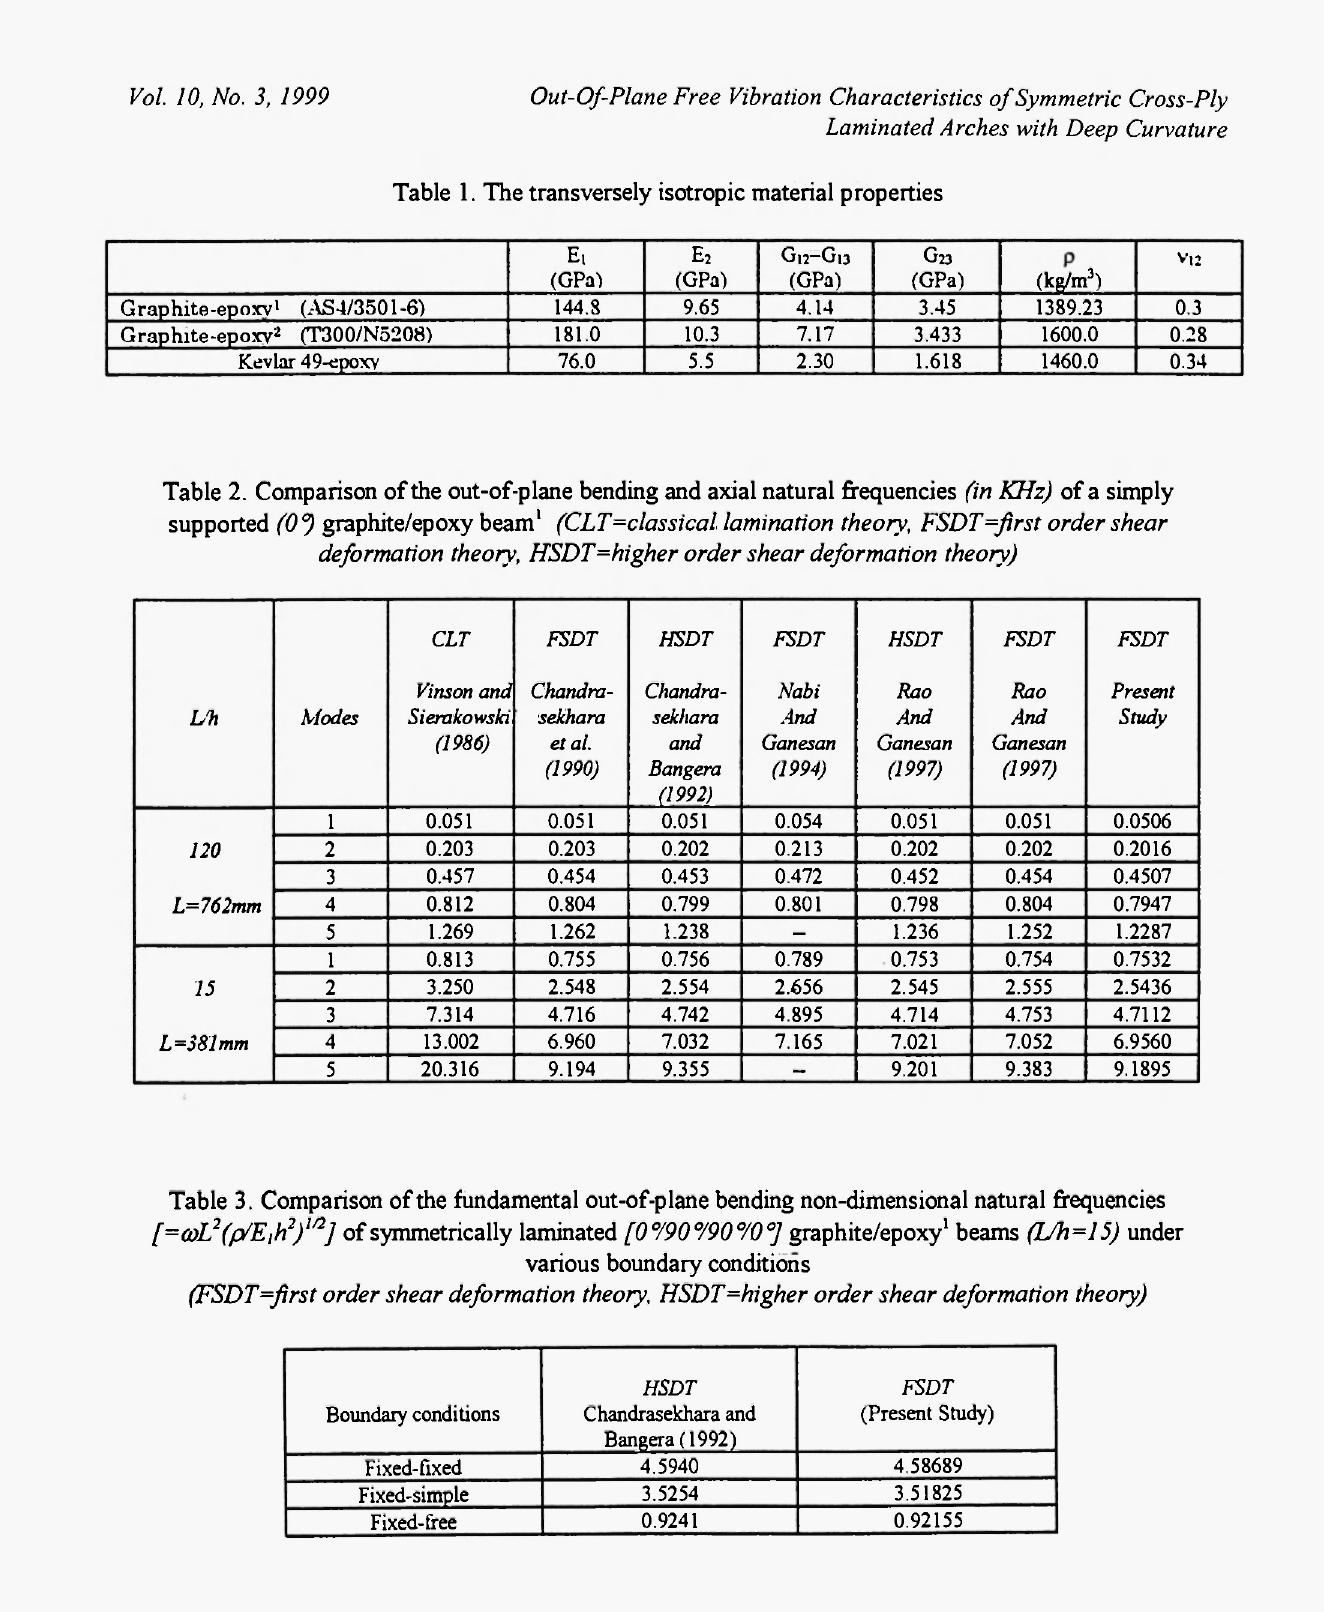
Table 3. Comparison of the fundamental out-of-plane bending non-dimensional natural